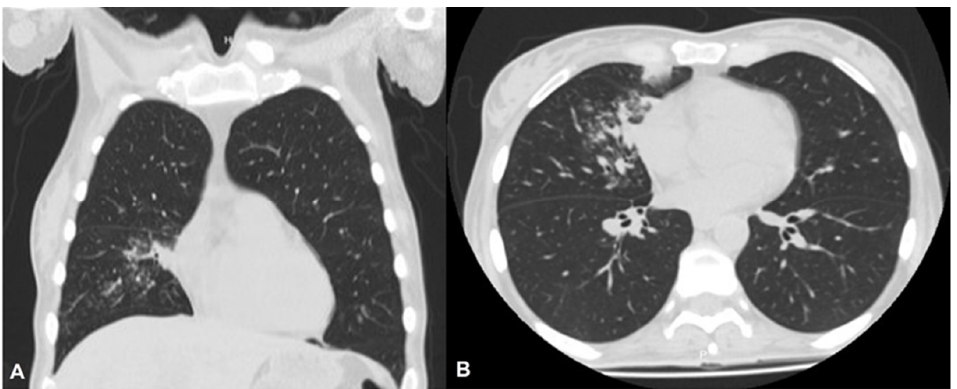
Figure 1. High-resolution chest tomography. (A) Coronal cut of high-resolution chest tomography showing expanded lung parenchyma. (B) Transversal cut of high-resolution chest tomography showing lung centrilobular nodules with a budding tree pattern, mainly in the middle lobe and a few in the left apical.